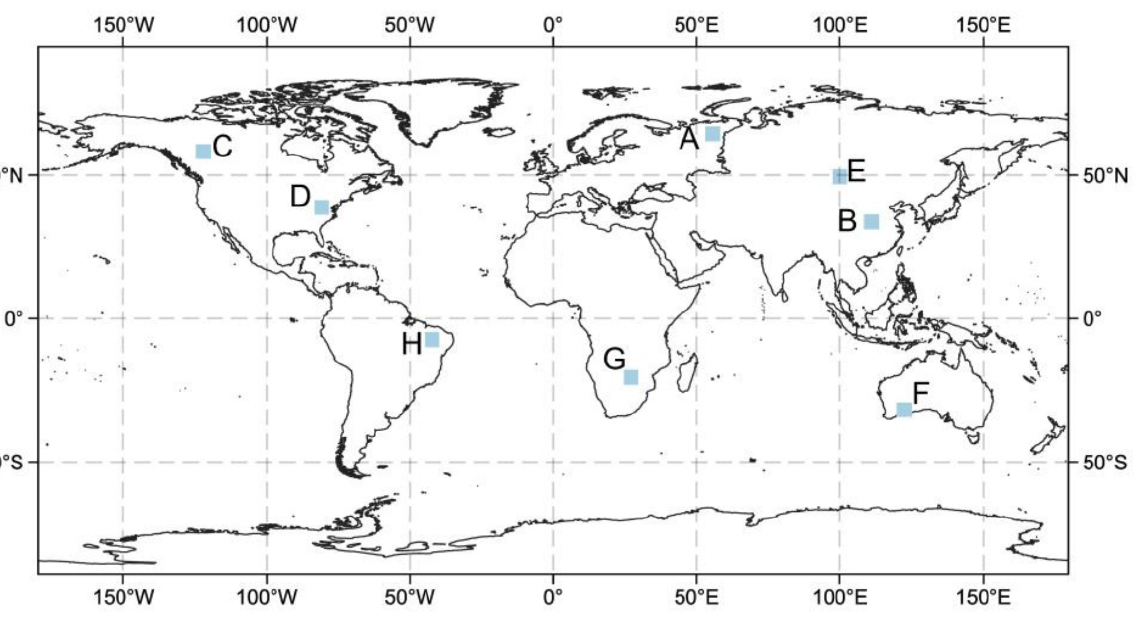
Figure 6. Locations of the eight selected verification areas that have eight representative vegetation types. (A) Siberian Evergreen Needleleaf Forests, (B) Asian Evergreen Broadleaf Forests, (C) North American Evergreen Needleleaf Forests, (D) North American Deciduous Broadleaf Forests, (E) Mongolian Steppe, (F) Australian Savanna, (G) African Shrub, (H) South American Tropical Shrub.